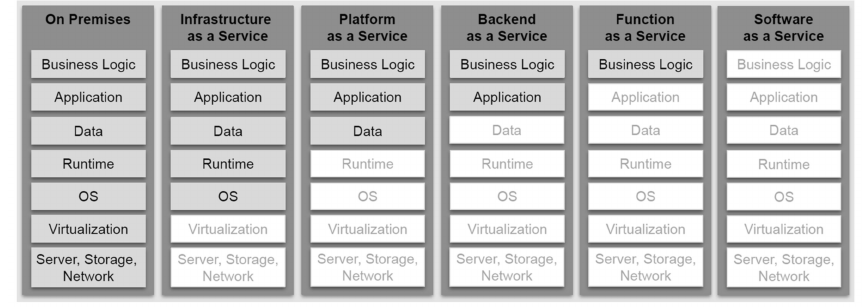
Figure 2. Comparison of di ff erent Computing Service models structure